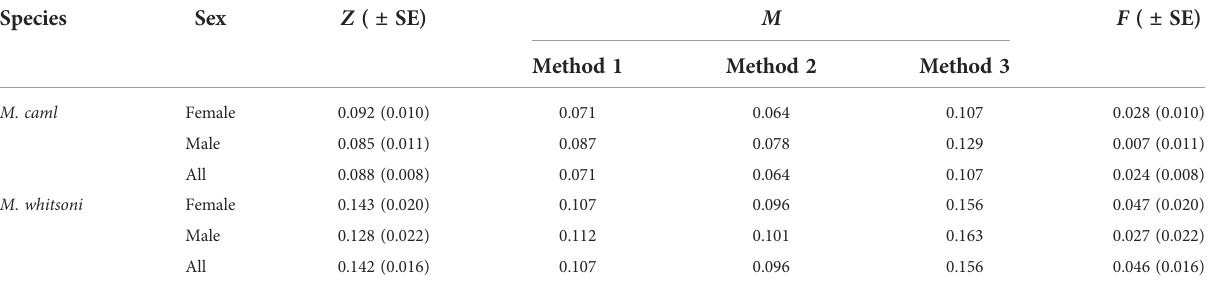
TABLE 5 Estimates of total mortality (Z), natural mortality ( M ), and fi shing mortality ( F ) of Macrourus caml and M . whitsoni in the Ross Sea region. Species